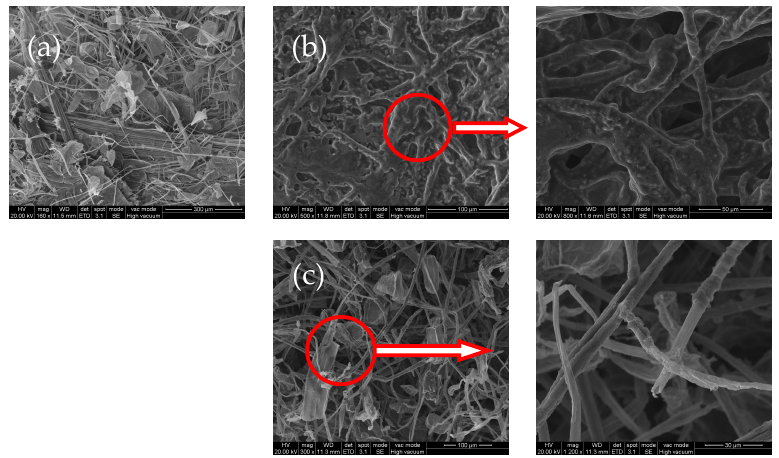
Figure 1. SEM images of ( a ) untreated cellulose, ( b ) P-doped cellulose, and ( c ) P,N-doped cellulose.